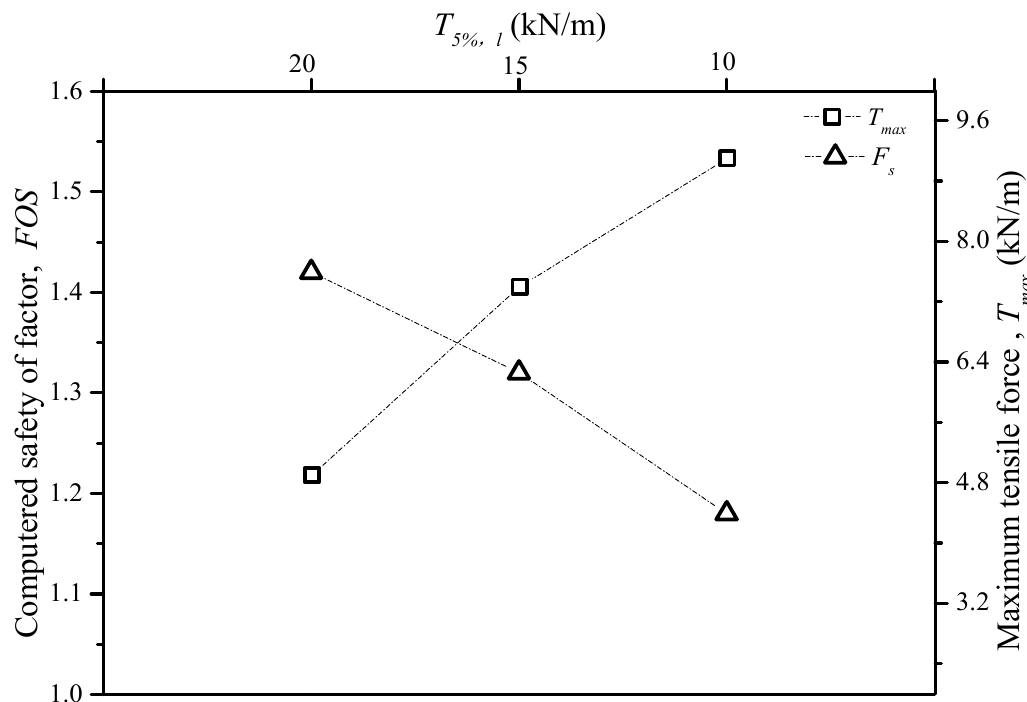
Figure 9. FOS and T max versus geotextile strength.